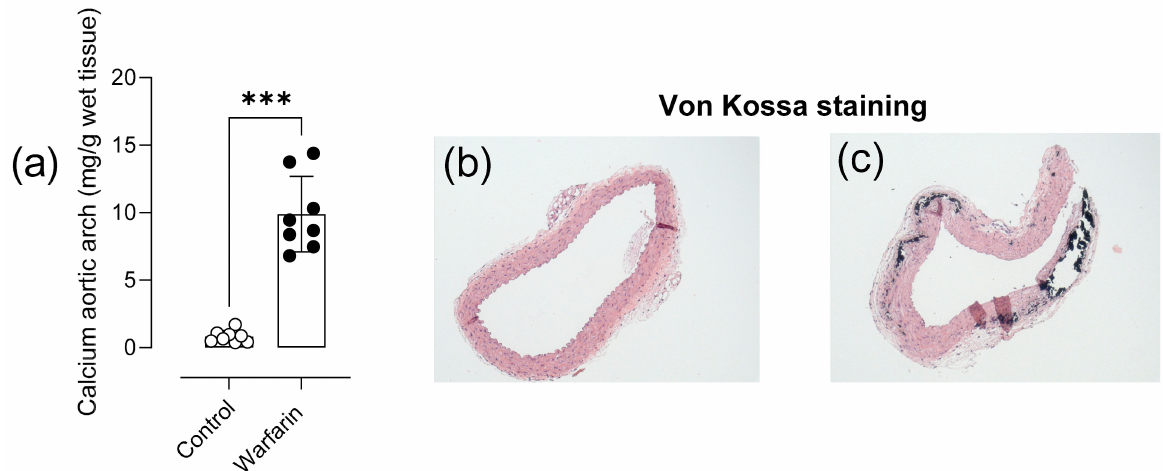
Figure 1. Warfarin treatment induces aortic media calcification. Quantification of the calcium content in the aortic arch ( a ) after 8 weeks of warfarin treatment. Von Kossa stained thoracic aortic section is shown for both control ( b ) and warfarin ( c ) treated mice (50 × magnification). Calcified lesions are Von Kossa positive. (Control: n = 8, Warfarin: n = 8). Two-tailed